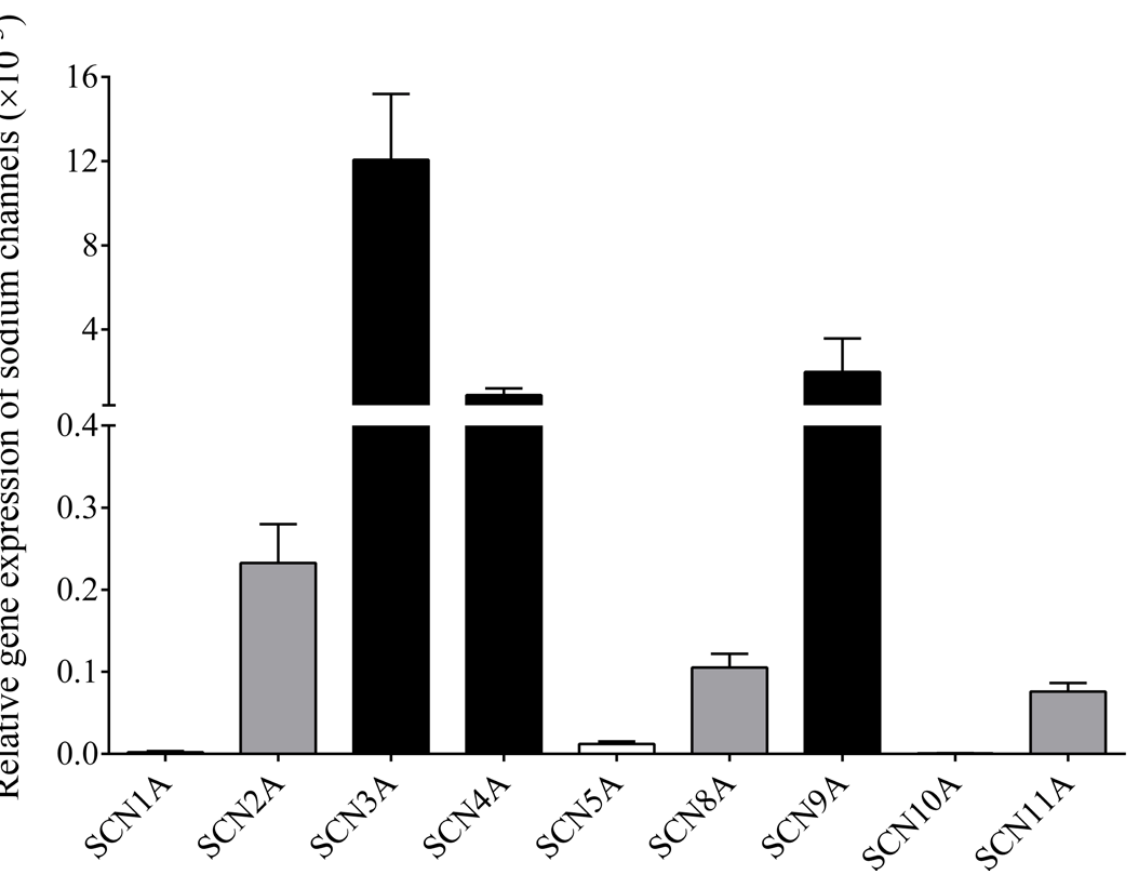
Figure 5. Analysis of the expression of multiple Na V channels by RT-qPCR in B cells. The relative expression of nine different Na V channels in human B cells was calculated based on the average copy number of the target genes normalized to the reference gene RLPLP0 (36B4). SCN3A, SCN4A and SCN9A (Na V 1.3, 1.4 and 1.7) subtypes were found to be highly expressed (black bars), while only low expression of SCN2A (Na V 1.2), SCN8A (Na V 1.6) and SCN11A (Na V 1.9) (gray bars) was detected. In addition, no expression was observed in SCN1A (Na V 1.1), SCN5A (Na V 1.5) and SCN10A (Na V 1.8) channels (white bars). Mean ± SEM are depicted, n =